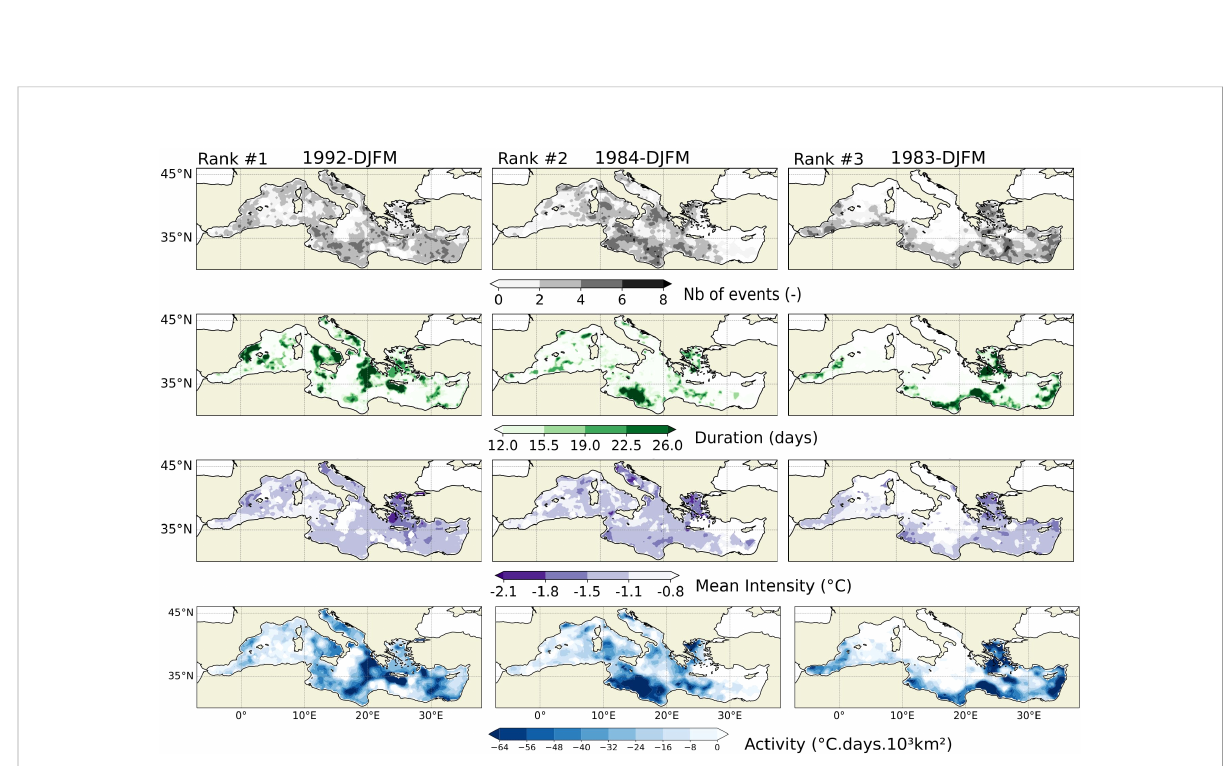
FIGURE 4 Same as Figure 3 but for MCSs in winter (DJFM). Negative values of activity traduce strong MCSs.